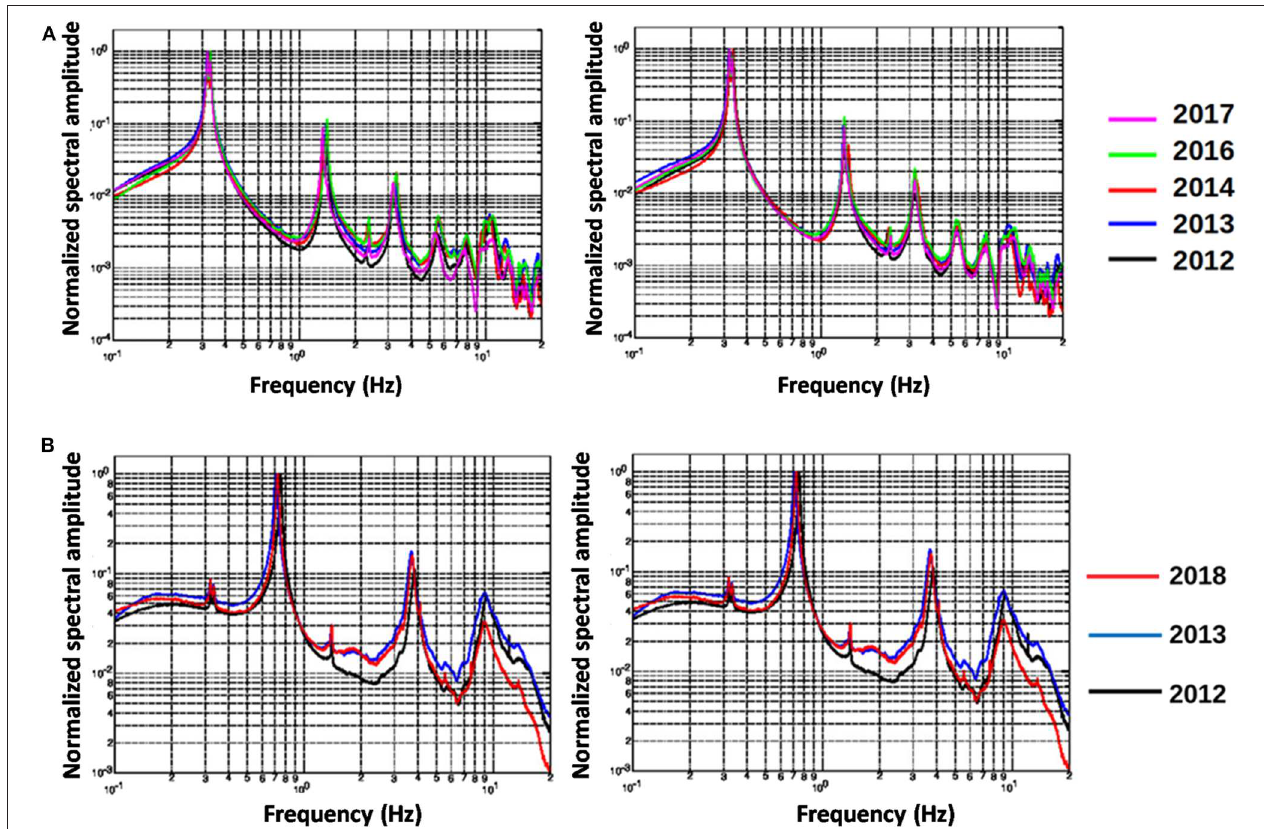
FIGURE 5 | Total average horizontal spectra (EW on the left, NS on the right) computed over the entire monitoring periods performed over several years according to the color legend for (A) Asinelli Tower and (B) Garisenda